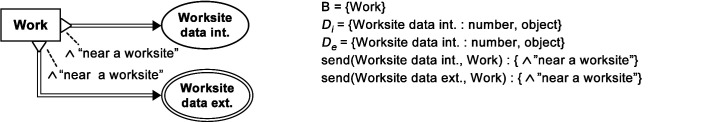
 BDRML representation of the Information Exchange near Worksites design pattern.